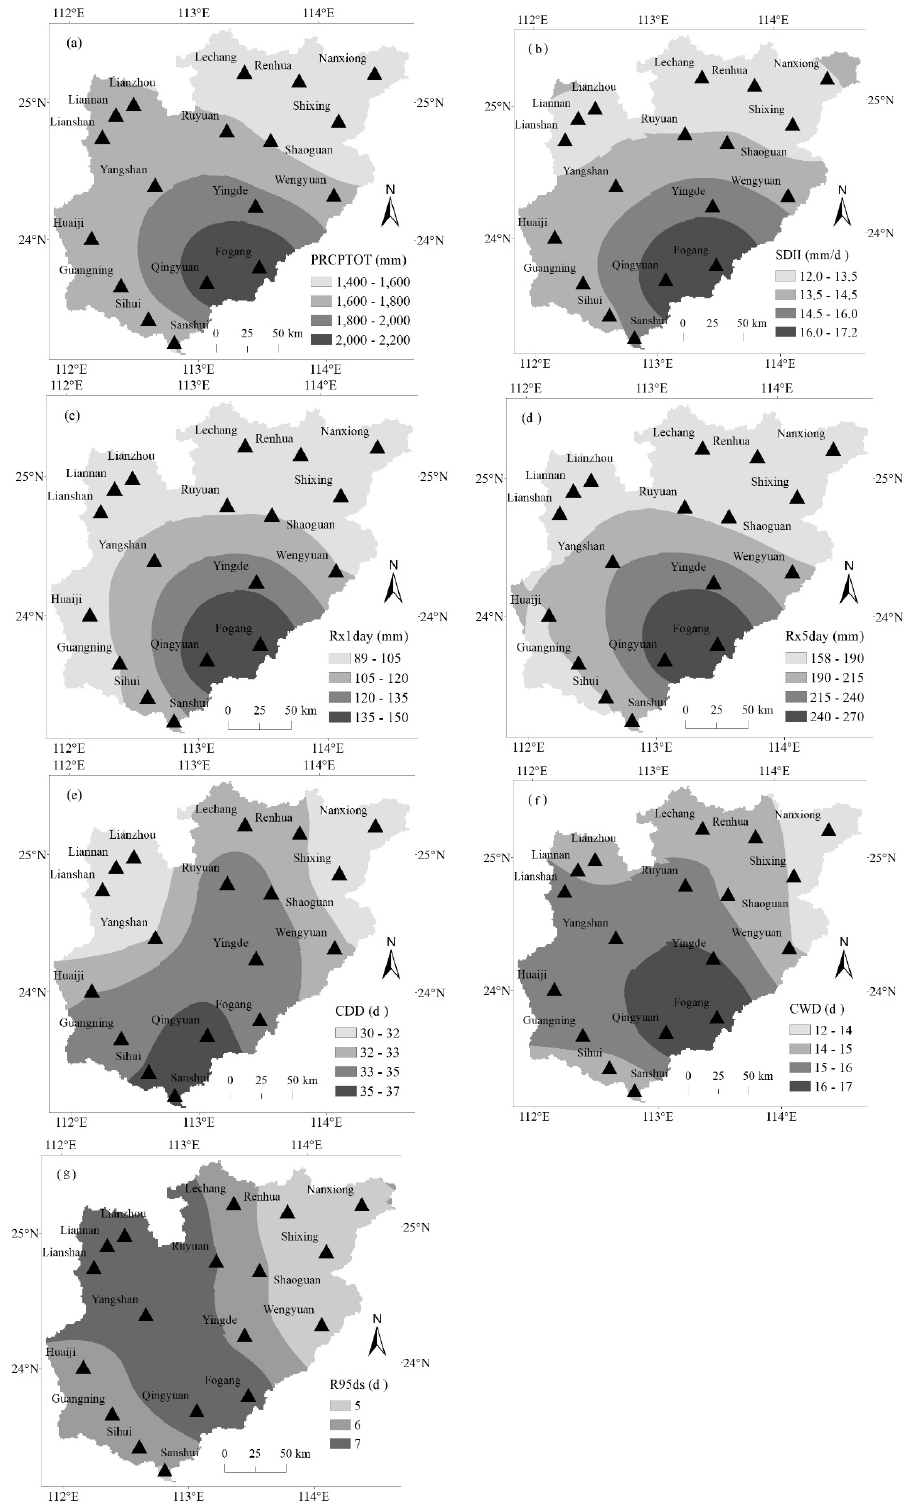
Figure 2. Spatial distribution of perennial mean of precipitation indexes PRCPTOT ( a ), SDII ( b ),